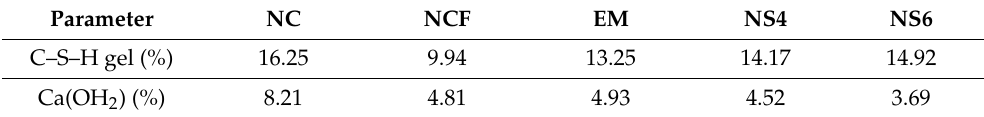
Figure 15. ( a – e ) EDS spectra of the designed concrete. Table 4. The hydration products percentages calculated by TGA results at 28